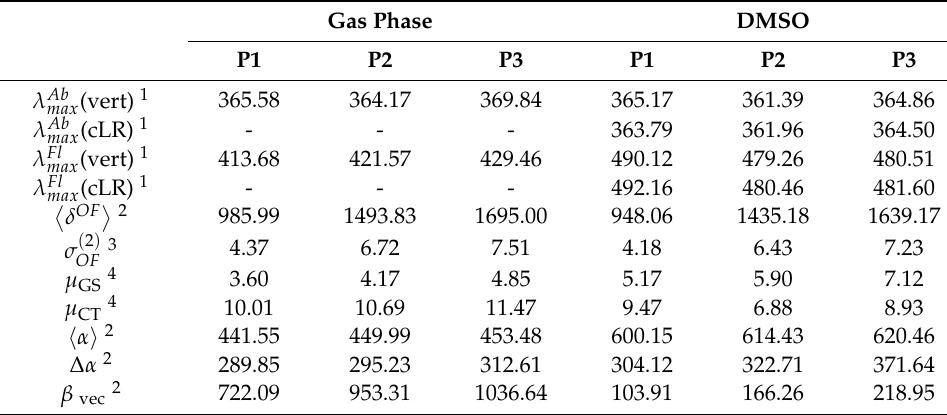
Table 2. Theoretical linear and nonlinear optical